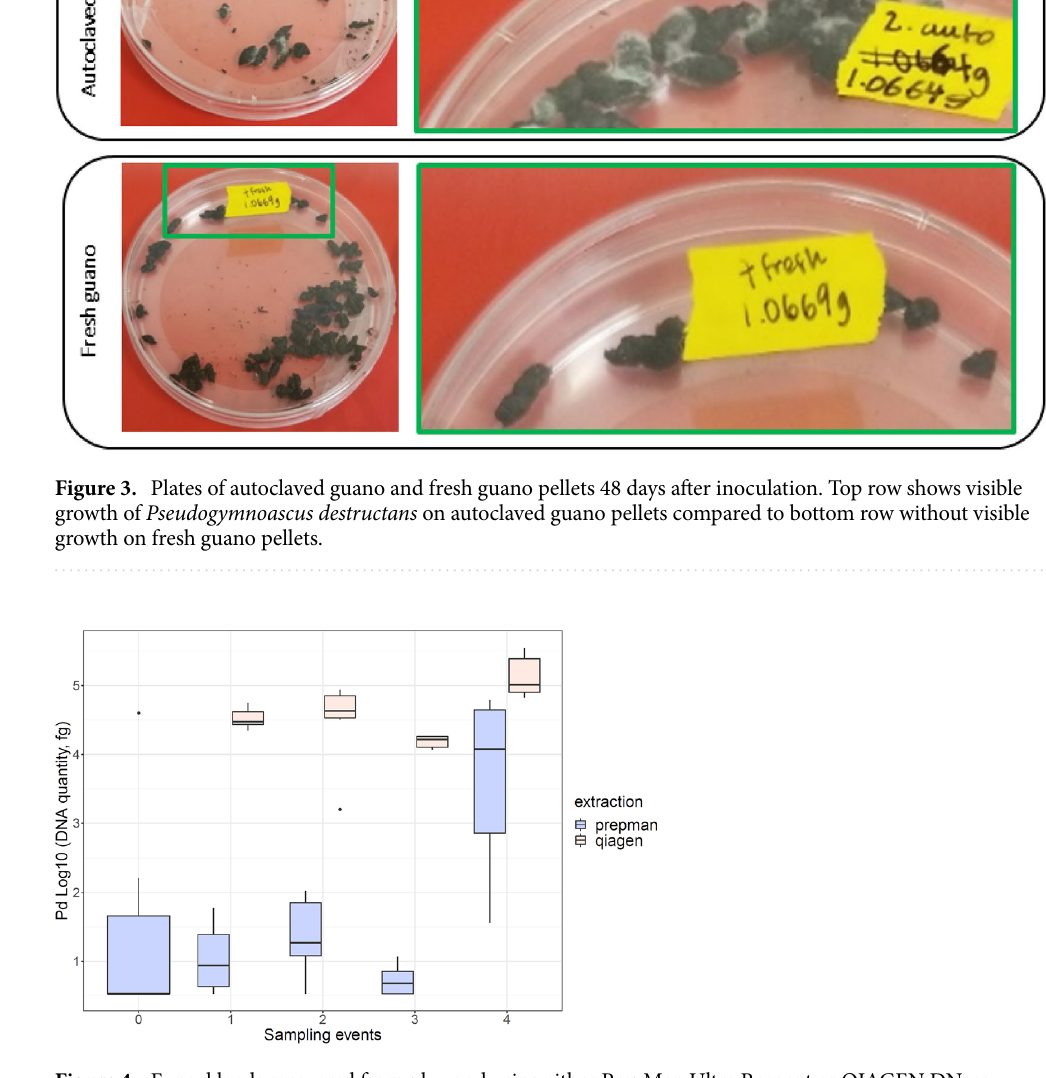
Figure 4. Fungal loads recovered from plywood using either PrepMan Ultra Reagent or QIAGEN DNeasy Blood and Tissue Kit for DNA